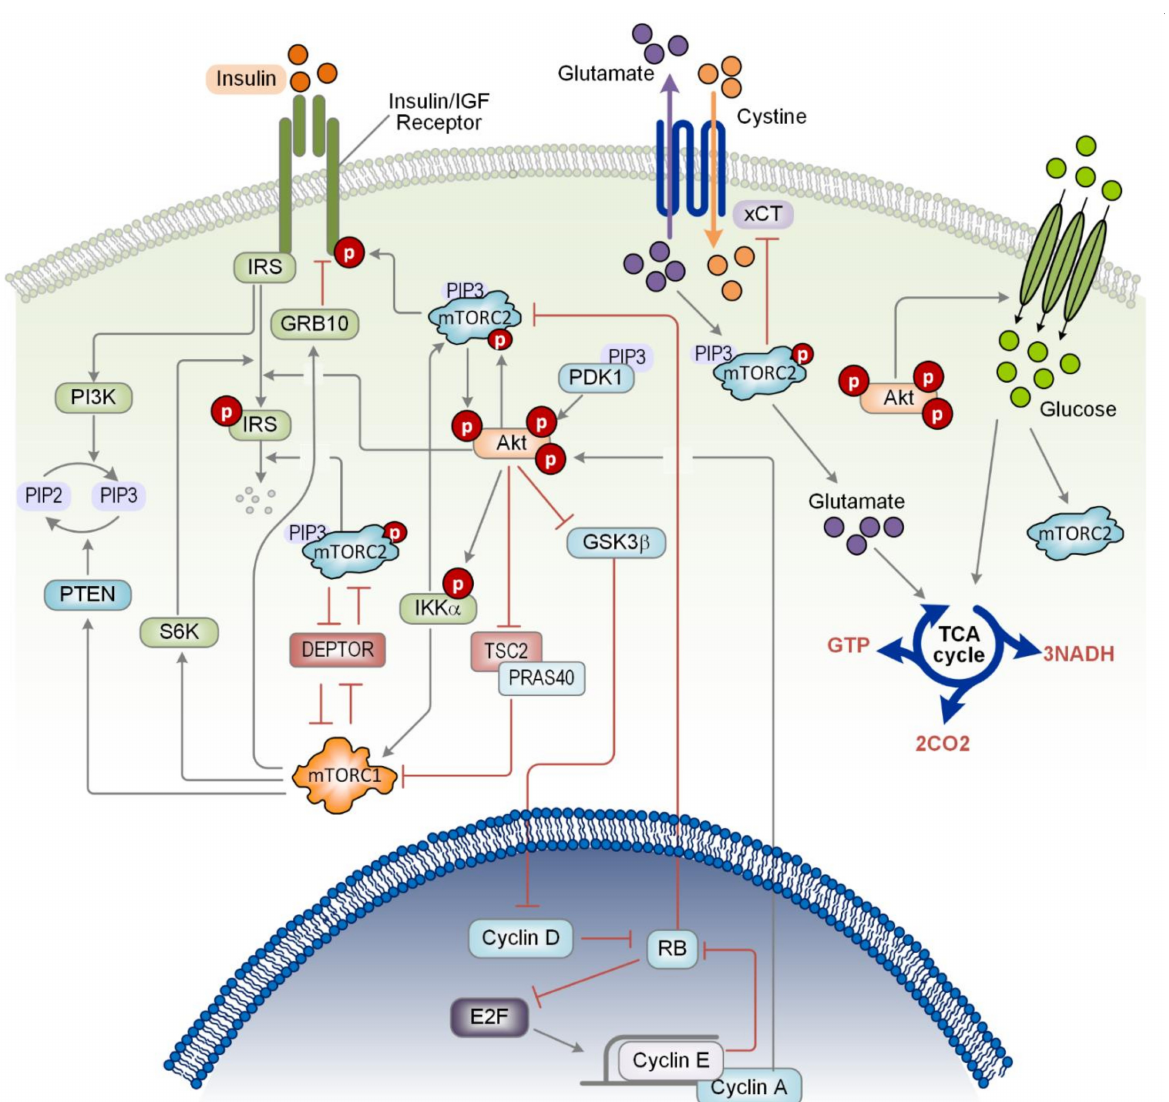
Figure 1. Schematic diagram of the canonical PI3K/mTOR signalling pathway and its interactions with the nutrient sources and cell cycle proteins. For a more detailed description see the main text. Grey arrows indicate positive regulations, while red arrows with blunt ends show negative regulations. Round boxes with P indicate phosphorylation events. The binding of growth factors (e.g., insulin) to IR/IGFR triggers activation of the receptors, promoting the recruitment of IRS and subsequent PI3K activation. PI3K converts PIP 2 into PIP 3 , which is reversed by PTEN. PIP 3 recruits mTORC2, PDK1 and Akt to be co-localised at the plasma membrane, leading to the full activation of Akt. Active Akt phosphorylates a plethora of target proteins, including TSC2, GSK3 β , IKK α and IRS1/2. Akt also phosphorylates Sin1 and increases mTORC2 activity. IKK α phosphorylates mTOR and stimulates the activation of mTORC1/2, but detailed mechanisms are unclear. DEPTOR displays a mutual inhibition with both mTORC1 and 2. mTORC1 and S6K1 inhibit IR/IGFR through Grb10 and IRS, respectively. mTORC1 upregulates PTEN expression through enhanced translation, while mTORC2 down- regulates IRS1 through ubiquitin mediated degradation. The cyclin A-CDK2 complex phosphorylates and promotes Akt activation. Hyper-phosphorylated Rb localized in the cytoplasm binds to Sin1 and suppresses mTORC2 activity. mTORC2 phosphorylates and down-regulates the functional activity of xCT, which inhibits glutamate efflux and leads to increased TCA cycle activity. Glucose uptake is enhanced by Akt, which leads to activation of mTORC2 through acetyl-CoA-mediated acetylation of